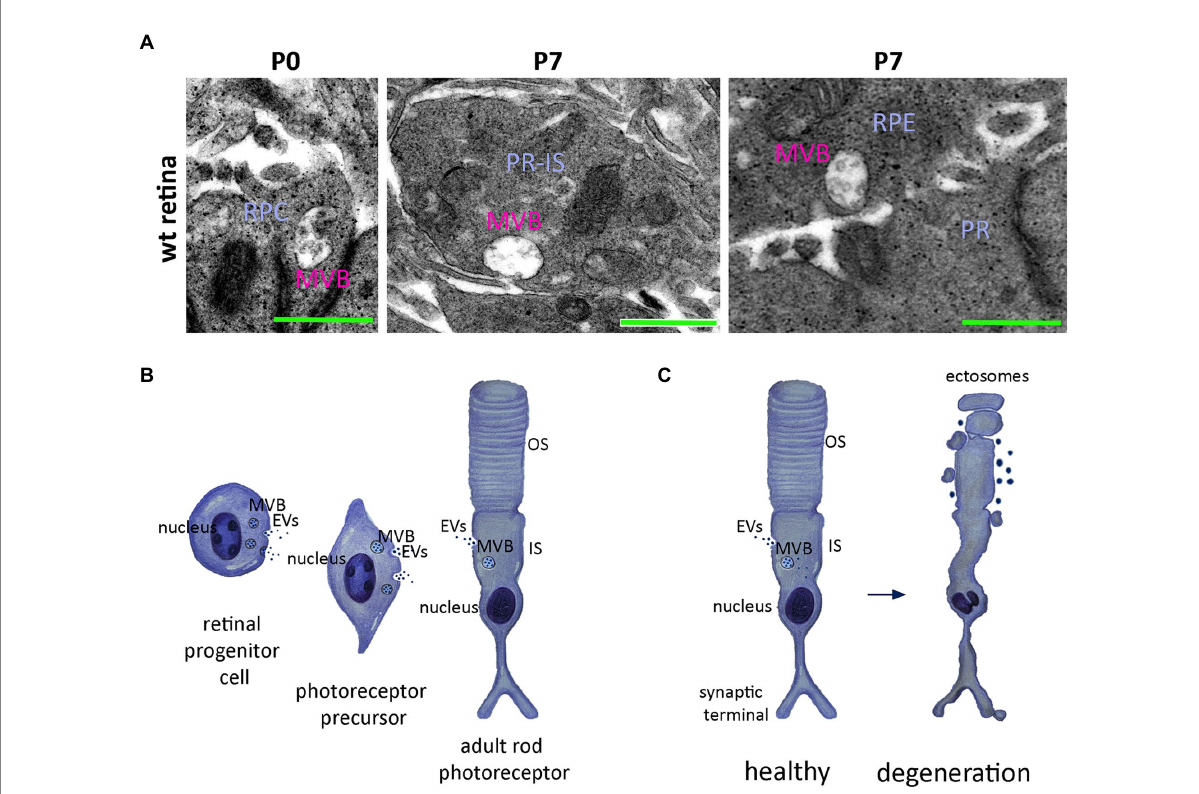
FIGURE 2 Potential roles of the extracellular vesicles release in mammalian rod photoreceptors. (A) Electro-microscopical analysis of the murine retina reveals Multivesicular bodies (MVBs) from left to right; in retinal progenitor cells (RPC) at postnatal day 0 (P0); at postnatal day 7 (P7) MVBs are obvious at the area of the developing photoreceptor inner segment (PR-IS), in close proximity to the photoreceptor membrane indicating potential release in the surrounding photoreceptors. On the right side, at P7 MVBs are also obvious in retinal pigmented epithelium (RPE) cell again in close proximity to the cell plasma membrane and in the apical side; facing the developing neuroretinal photoreceptors; (B) Schematic representation of the developing retinal progenitor cell (RPC) towards rod photoreceptor precursors indicating release of extracellular vesicles (EVs) originating either from MVBs or budding from the membrane. The release is reduced in adult stages of photoreceptor development where the cell has formed the inner (IS) and outer (OS) segment; ( C ) Schematic representation of the ectosome release by the malfunctioning rod photoreceptor cilium-the outer segment- in rds -/- mutant photoreceptors (right) compared to the normal MVB biogenesis and release or direct building of EVs in healthy